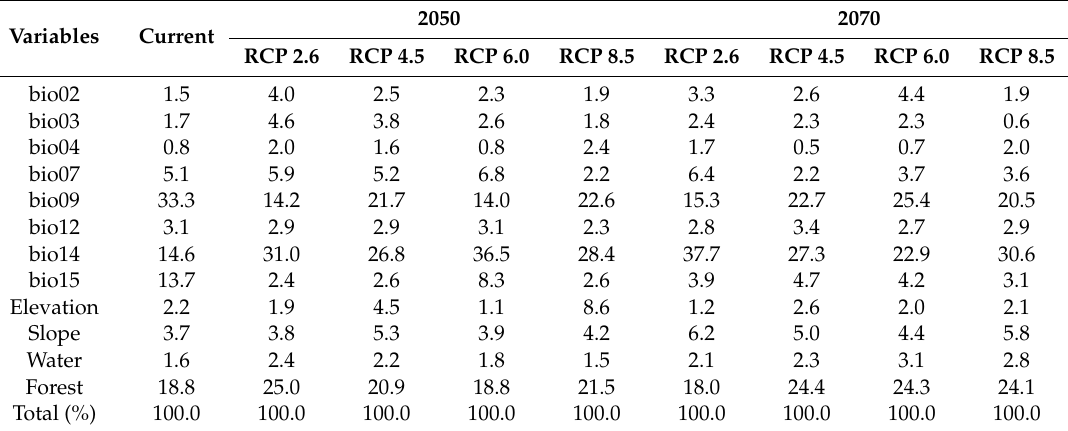
Table 2. Relative contributions (%) of environmental variables to the MaxEnt model under current conditions and climate change scenarios of the spectacled bear in Amazonas